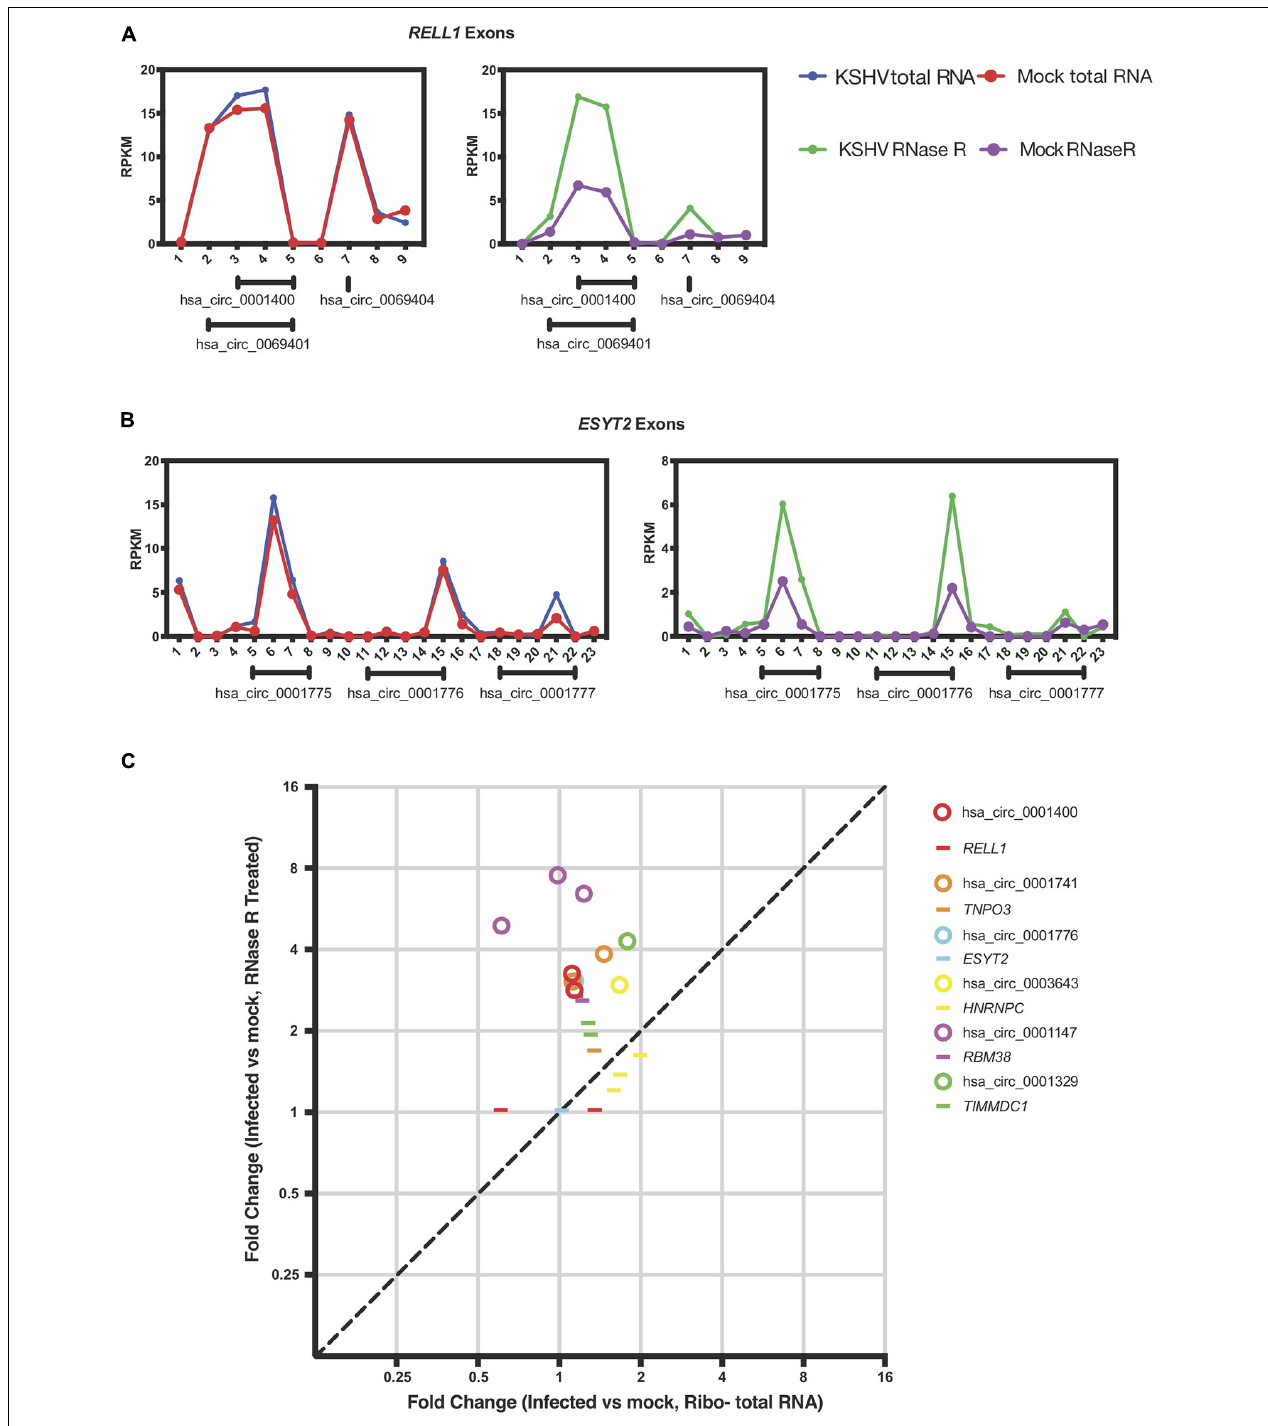
FIGURE 4 | KSHV induces circRNA expression post-transcriptionally. (A,B) Exon-wise analysis of read-counts upon KSHV infection in RELL1 (A) and ESYT2 (B) loci. Shown are RPKM (reads per kilobase in million reads) of total RNA Seq (left) and circRNA-Seq (right). Numbers in x-axis corresponds to exon number from 5 (cid:48) ends. Under each panel, locations of human circRNA in circBase are shown. (C) Exon-wise fold-change of select genes comparing infected and non-infected human primary endothelial cells. Circles are exons that are part of circRNAs and lines are exons that are not known to be circRNAs according to circbase. Only exons with aligned read counts > 0.05 RPKM are